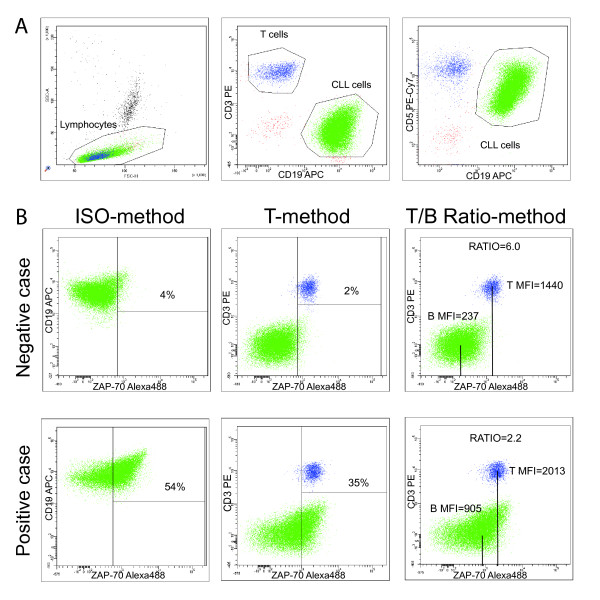
Flow cytometric analysis of ZAP-70 expression (test set). PB cells of CLL samples were analyzed after staining with anti-CD19-APC, anti-CD3-PE, anti-CD5-PECy7 and AlexaFluor488-conjugated isotype control or anti-ZAP-70 antibodies. Panel A shows the gating strategies used to select lymphocytes in the left plot, CLL cells (CD19+/CD5+/CD3-) or T cells (CD19-/CD5+/CD3+) in middle and right plots, upon gating on lymphocytes. Panel B contains plots showing a representative ZAP-70 negative (upper row) and a representative ZAP-70 positive (lower row) sample, both analyzed according to the three different approaches utilized to evaluated ZAP-70 expression. The ISO- T-, and T/B Ratio-method readouts are shown respectively in the left, middle and right panels. For the ISO-method marker was set to have <1% CLL positive cells with isotypic control. For the T-method, marker was set on the left edge of T cells cluster, to have about 98% of positive cells. For the T/B Ratio-method the ratio was calculated directly from MFI values as separately read from T cell and CLL cell gates defined in panel A.